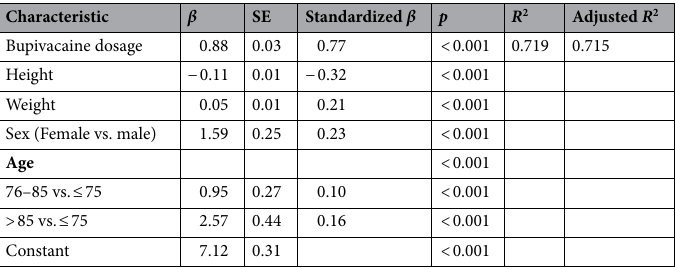
Table 3. Selected predictors of peak spinal block level after the model selection. β , regression coefficient; SE, standard error; R 2 , coefficients of determination.